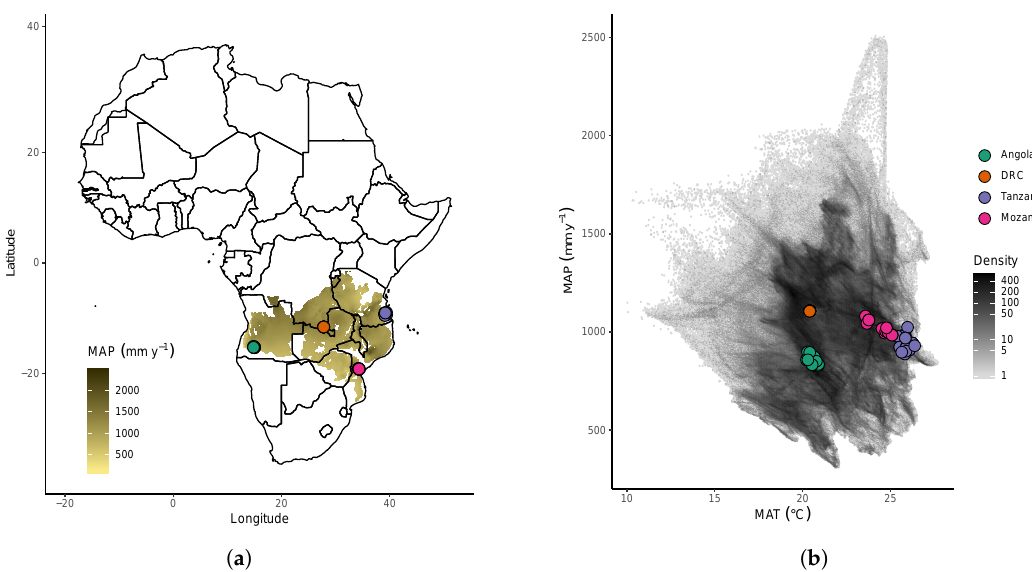
Figure 1. Locations of plots used in this study, by ( a ) geographic location with respect to the distribution of miombo woodland vegetation (shaded brown according to mean annual precipitation) [1], and ( b ) showing the plot locations compared to the climate space of the miombo ecoregion estimated using the WorldClim dataset over the miombo woodland vegetation extent with a pixel size of 30 arc seconds (0.86 km 2 at the equator) [34]. Please note that the density colour scale is log-transformed for visual clarity. Table 1. Description of each group of plots used in the analysis. MAT = Mean Annual Temperature, MAP = Mean Annual Precipitation, CWD = Climatic Water Deficit, DD = Decimal Degrees. Plot Group MAT MAP CWD Latitude Longitude N Plots N Species ( ◦ C) (mm y − 1 ) (mm y − 1 ) (DD) (DD) Bicuar NP 20.5 864 − 815 − 15.12 14.81 15 49 DRC 20.4 1115 − 762 − 11.49 27.67 12 89 Mozambique 24.4 1029 − 662 − 18.95 34.16 15 162 Tanzania 25.8 956 − 754 − 9.05 39.05 22